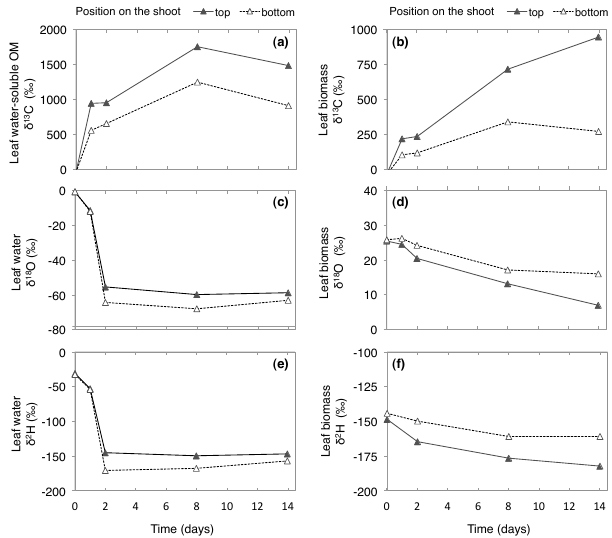
Figure 2. Incorporation of the gaseous labels (enriched 13 CO 2 , de- pleted 2 H 18 O) into the plant matter. (a, b) δ 13 C, (c, d) δ 18 O and (e, 2 f) δ 2 H signature (in ‰) within leaves sampled at the top (solid line, black triangles), or at the bottom (dashed line, white triangles) of the shoot. Illustrated are the signatures of (a) the leaf water-soluble OM, (b, e, f) leaf biomass and (c, e) leaf